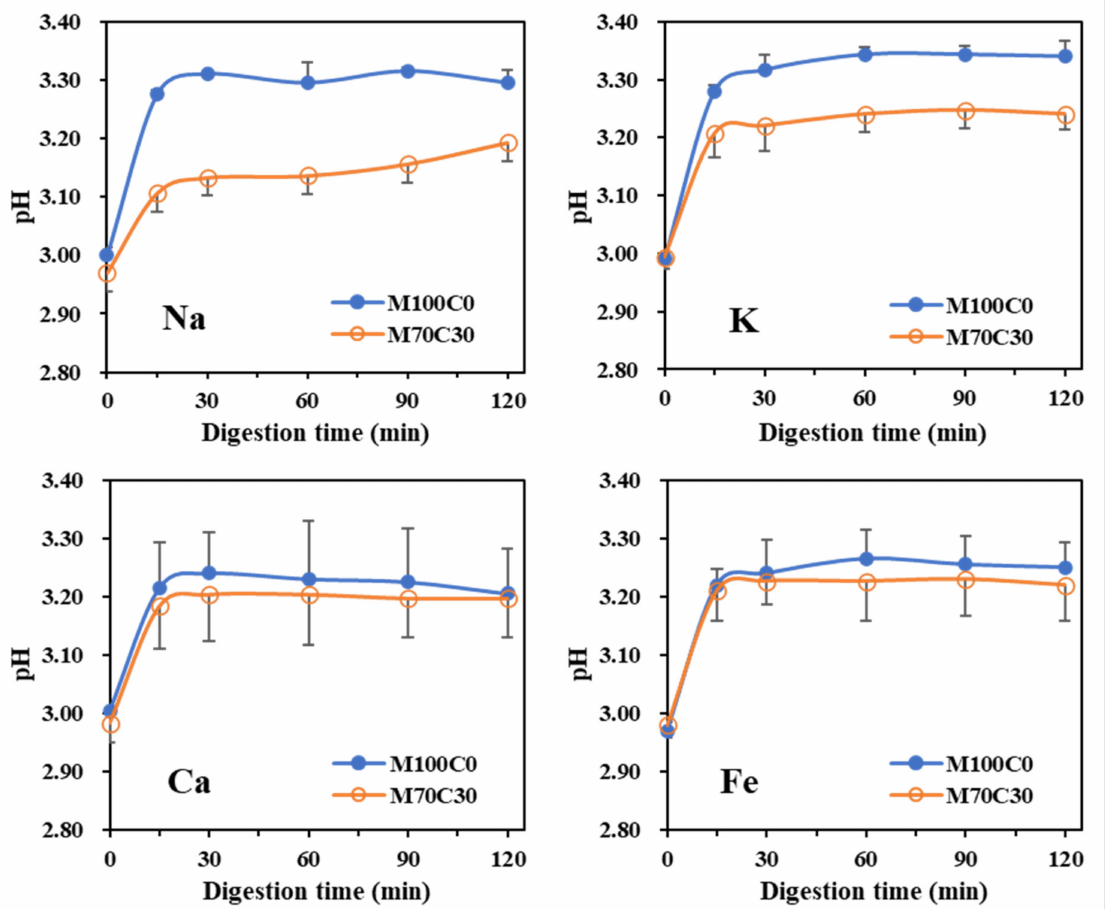
Figure 5. Changes of pH values for emulsions during